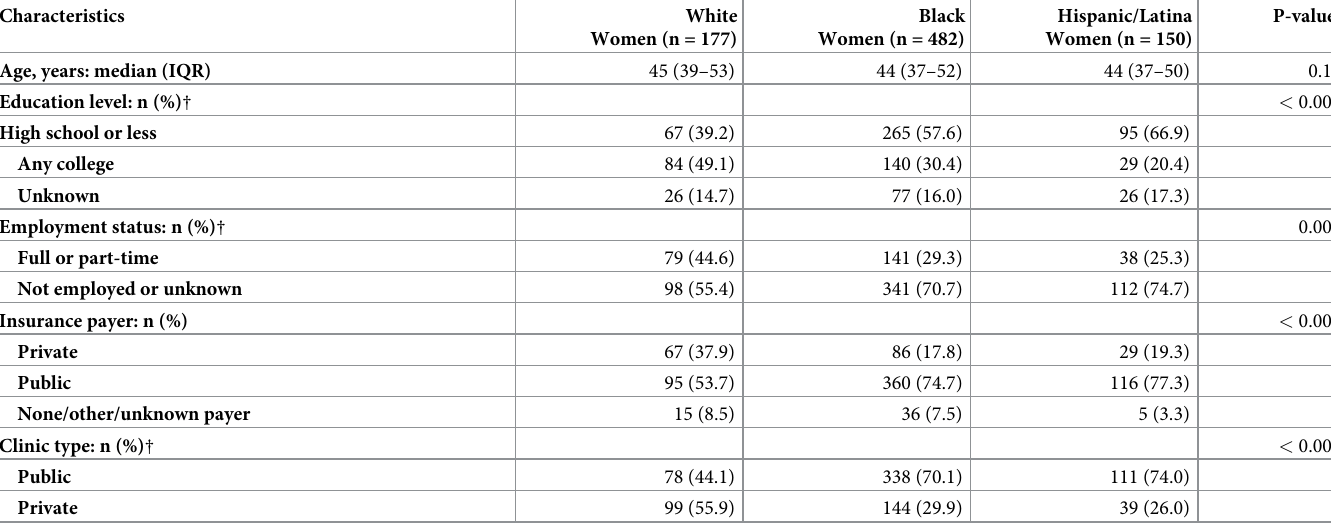
Table 1. Characteristics of Women Participants At Baseline†, by Race/Ethnicity, The HIV Outpatient Study, 2010–2015 (N = 809).